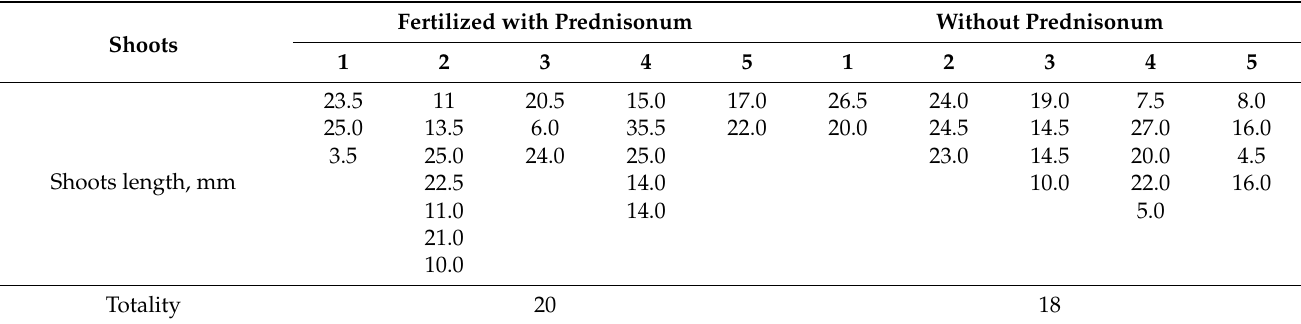
Table 2. Growth of energetic willow shoots after four months of cultivation. Fertilized with Prednisonum Without Prednisonum